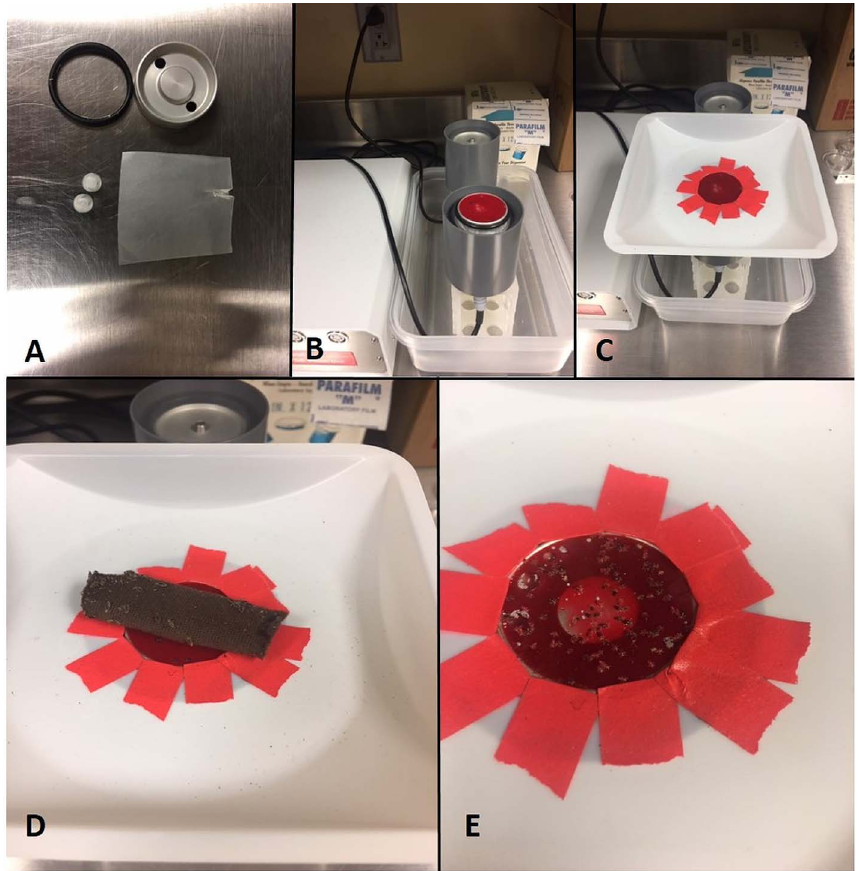
Figure 1. Visual of in vitro feeding process. (A) A 2 mL metal reservoir is assembled using Para fi lm M, a rubber O-ring, and plastic plugs provided with the Hemotek apparatus. (B) The reservoir is fi lled with 2 mL of de fi brinated rabbit blood using sterile technique and screwed into an inverted FU1 feeding unit. (C) A barrier cut from a plastic weighing boat is placed on top of the Para fi lm membrane forming a gentle seal that prevents escape of the lice. (D) The rearing substrate harboring lice is placed directly on the feeding membrane after turning on the device to pre-warm for 2 – 3 min. (E) Within minutes, lice can be seen leaving the harborage and beginning to feed. By 30 min, feeding rates >90% are common. Many fed lice return to the harborage independently after engorging, but lice remaining on the membrane after feeding can be returned to the harborage by gently swabbing it over the membrane